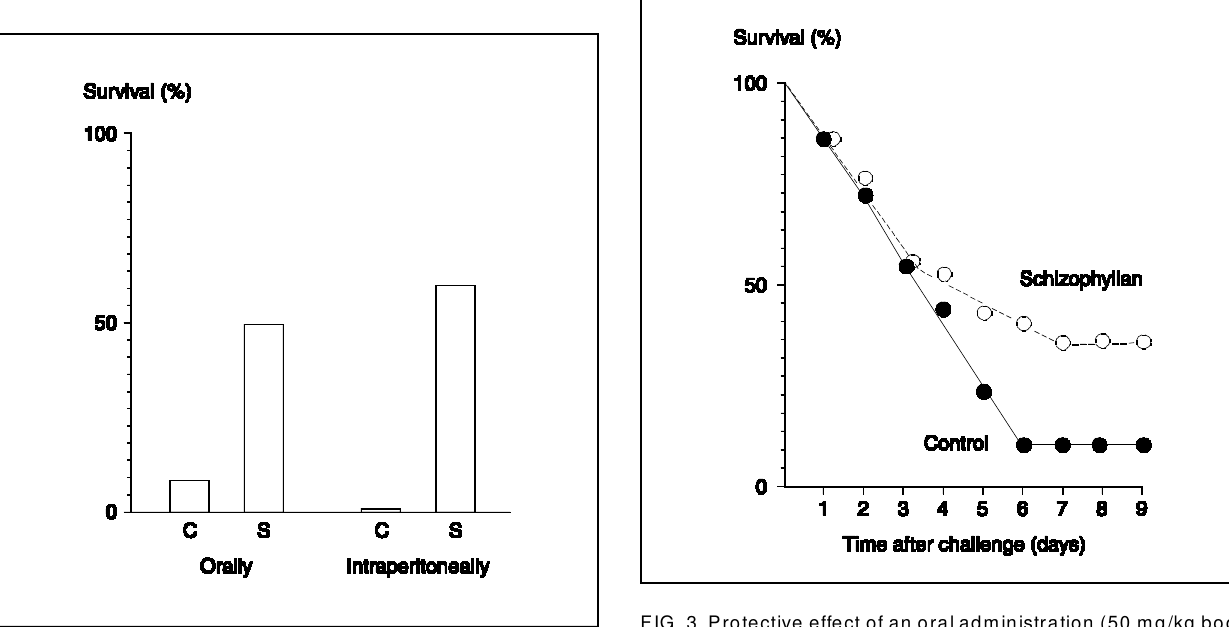
FIG. 2. Protective effect of schizophyllan (S) against Sendai virus infection in mice. C, control.